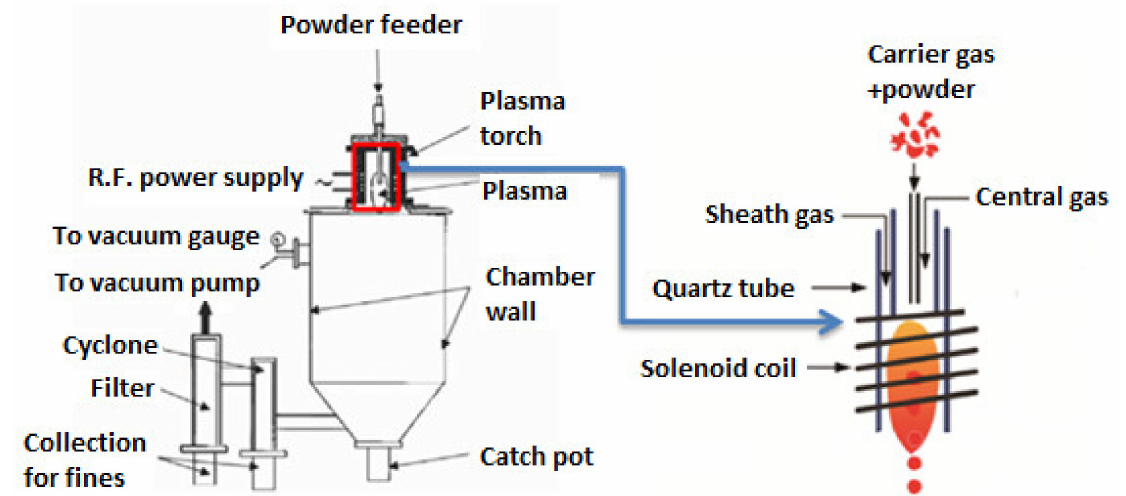
Figure 1. Schematic diagram of a plasma torch, adapted from